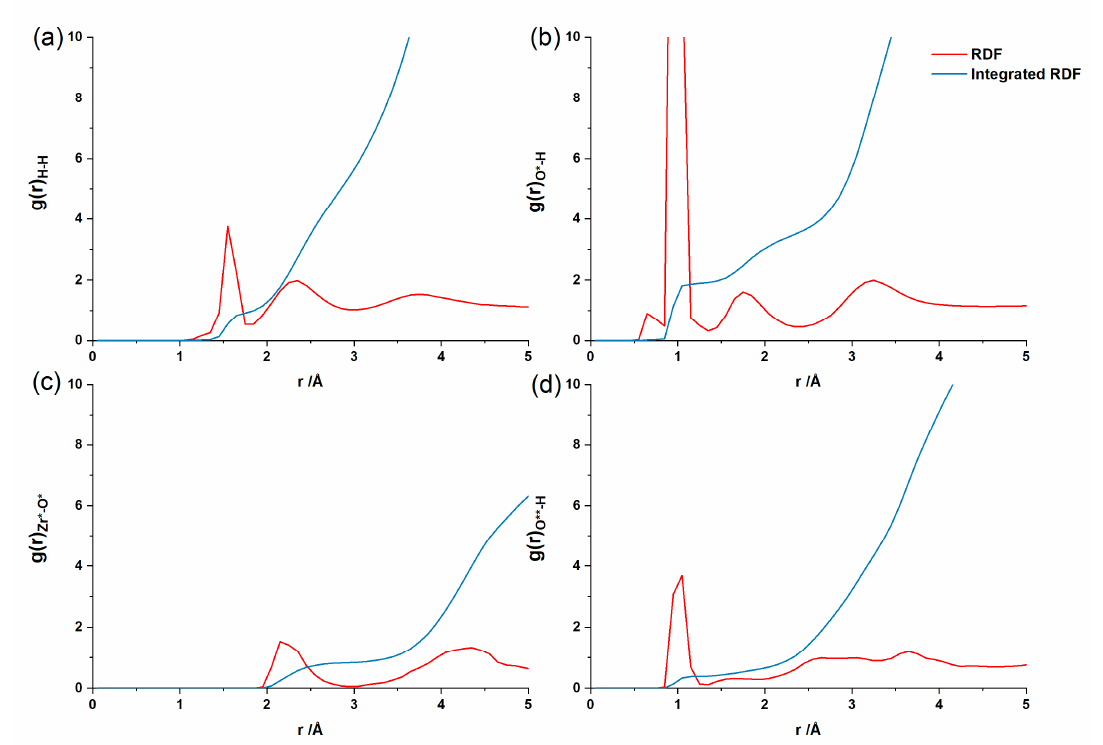
Figure 6. Radial distribution functions (RDFs) and their integrated RDFs. g( r ) H–H between H atoms in the water molecule ( a ), g( r ) O*–H between O atoms in the water molecule and H atoms in the water molecule ( b ), g( r ) Zr*–O* between Zr atoms on the surface of ZrO 2 and O atoms in the water molecule ( c ) and g( r ) O**–H between O atoms on the surface of ZrO 2 and H atoms in the water molecule ( d ).